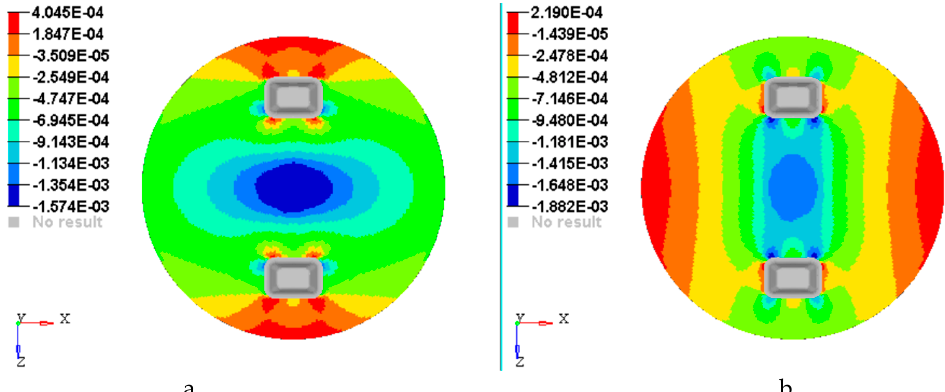
a. b. Figure 18. Plot strain on the upper face of layer 5: ( a ) Strains x ε with respect to Ox axis; ( b ) strains z ε with respect to Oz axis. Figure 19. Plot of the Von Mises stress distribution on the manhole cover analysed. Other important output parameters from the FEA analysis are: Von Mises stress (VMS), maximum and minimum Principal stress. To interpret and explain the strength of the composite manhole cover, Figures 19 and 20 show the stress plot results. A maximum of VMS of 9.66 MPa is obtained in the handling area of the manhole cover. The reason for this result could be a stress concentrator caused by the transition area from five layers to four layers because the OSB layer is missing from the sandwich structure corresponding to area C (see Figure 3). Figure 20 shows the maximum and minimum principal stress on the lower face of the first layer and on the upper face of the fifth layer (last layer), respectively.